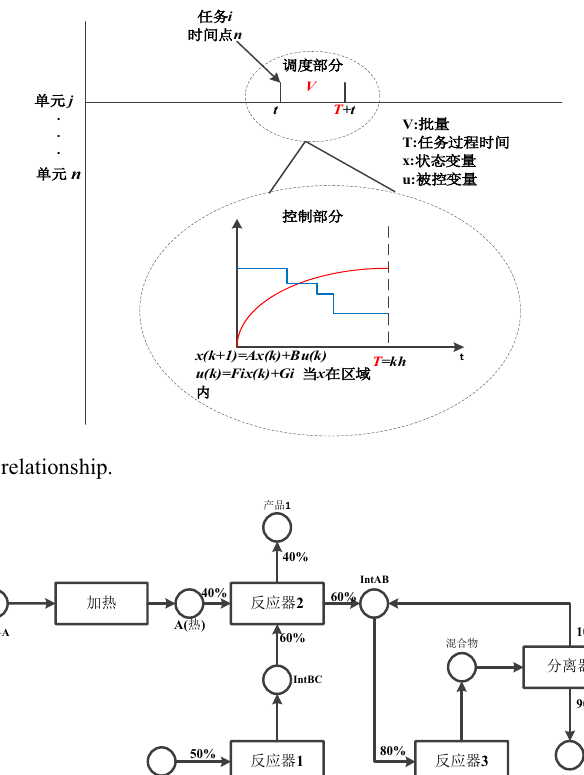
Fig. 3. Flow sheet.